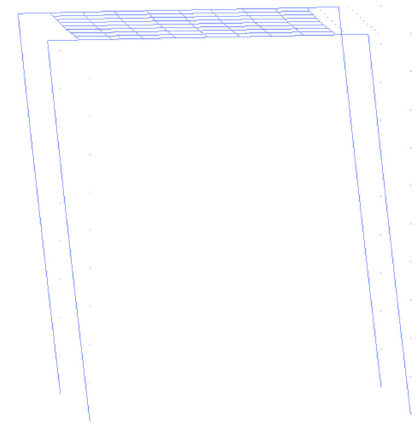
Figure 15. Third mode shape of portal frame 3D model, (cid:1858) = 17.84 Hz .